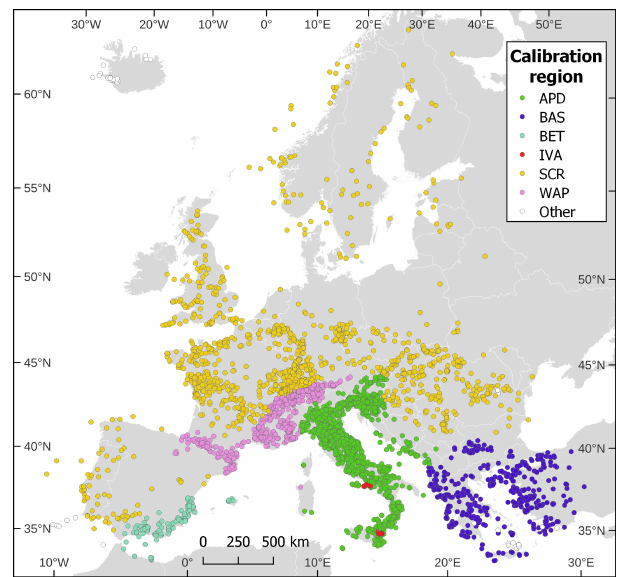
Figure 4. Subdivision of earthquakes in EPICA represented accord- ing to the calibration regions defined for the assessment of the pa- rameters. APD: Apennines, north-eastern Alps and Dinarides; BAS: broad Aegean, shallow; BET: Betics; IVA: Italian volcanic areas; SCR: stable continental region; WAP: Western Alps and